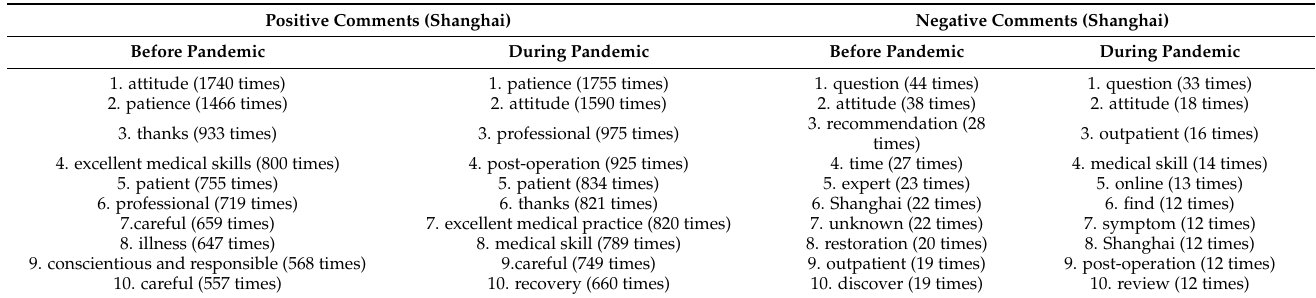
Table 6. Frequently Used Words in Comments (Shanghai).